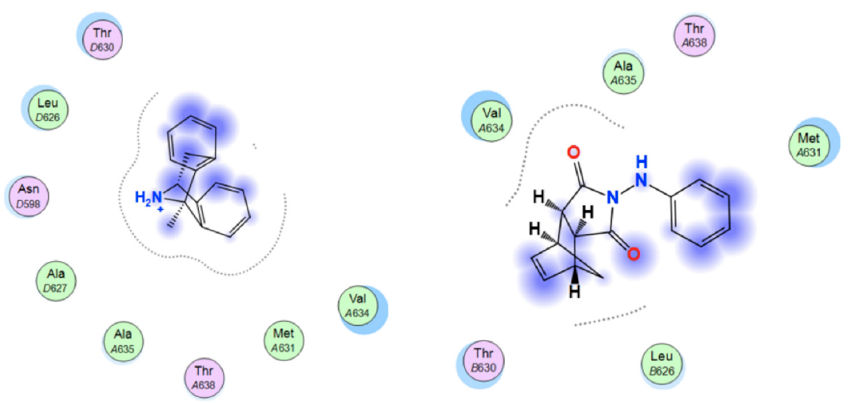
Figure 6. ( A ) Top ranked docking pose of compounds 3 (magenta), 8 (blue) and 13 (yellow). The co-crystallized pose of MK-801 within the NMDA receptor ion channel is shown in green. ( B ) Superposition of MK-801 (green) with compounds 3 (magenta), 8 (blue) and 13 (yellow).